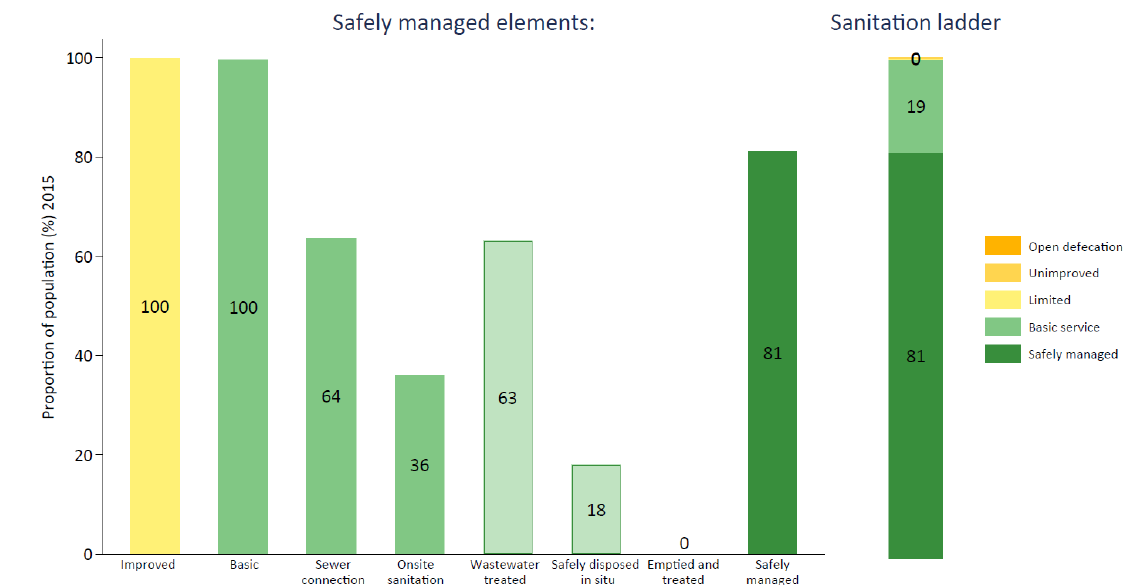
Figure 3. Estimation of safely managed sanitation services in rural Estonia. Source: WHO/UNICEF JMP